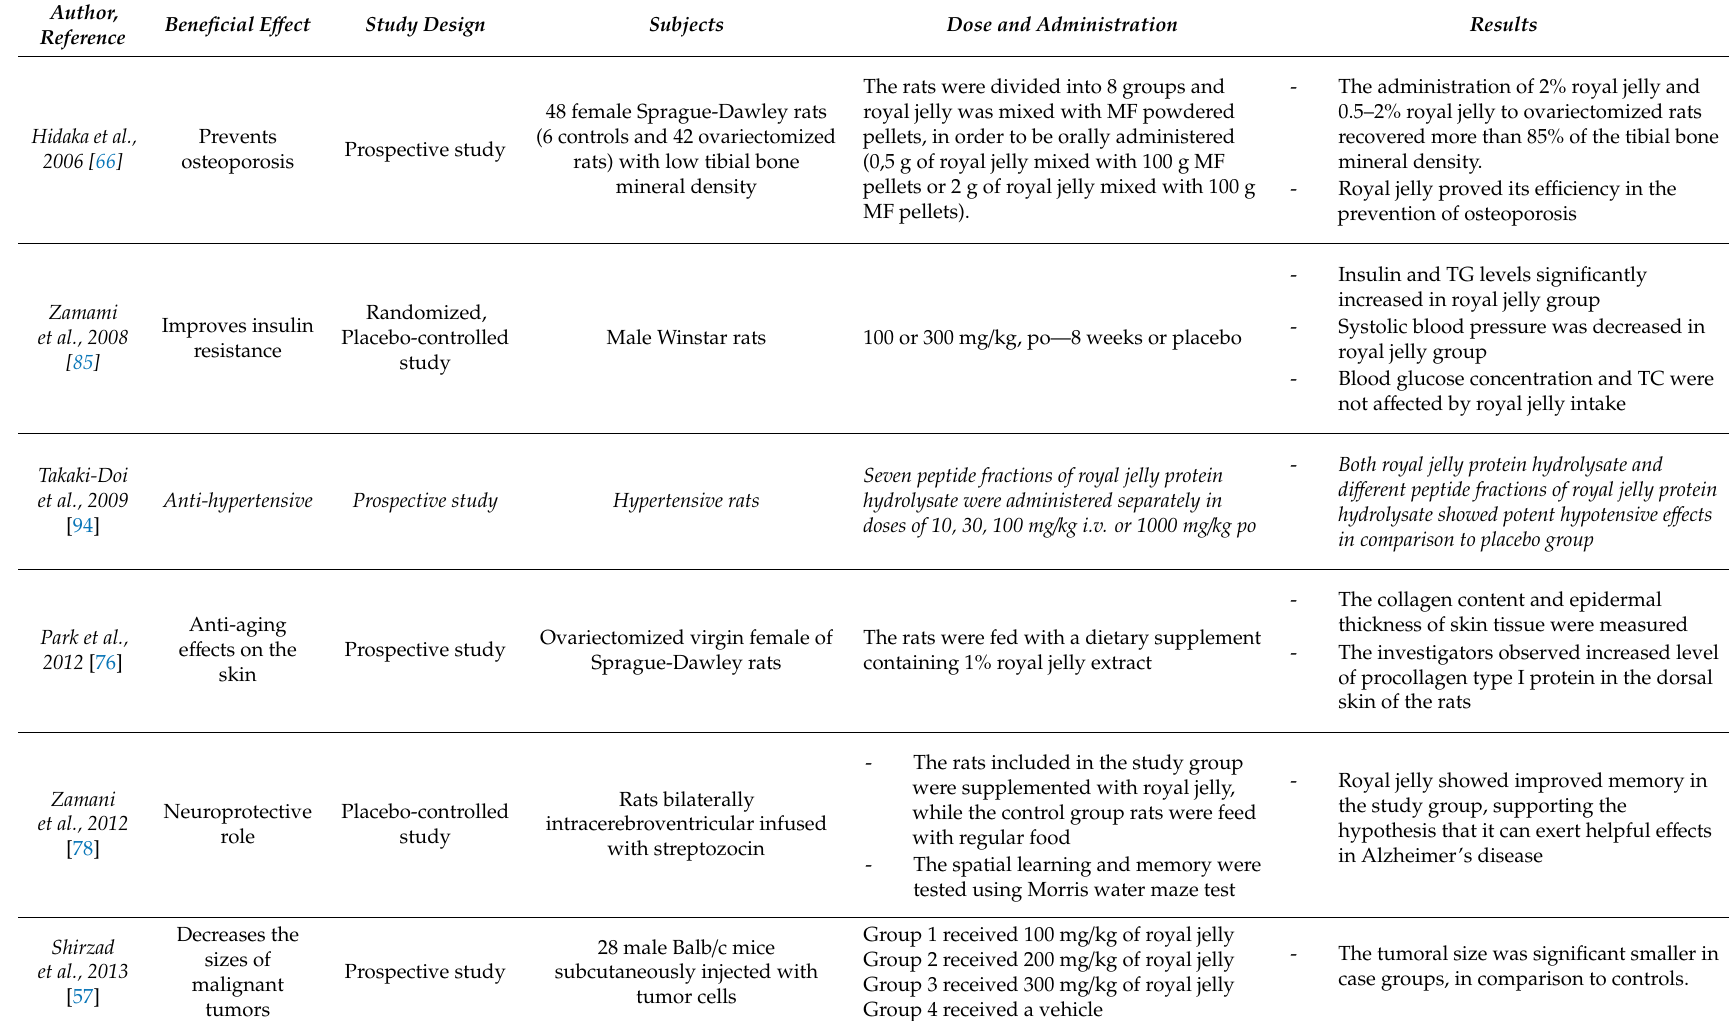
Table 2. Studies regarding beneficial e ff ects of royal jelly in menopause using animal models and cellular